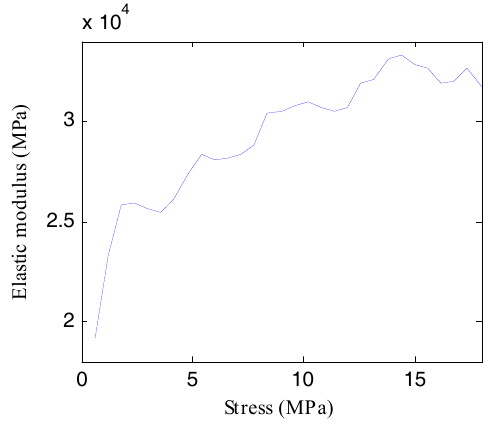
Figure 8. Elastic modulus development versus applied stress.